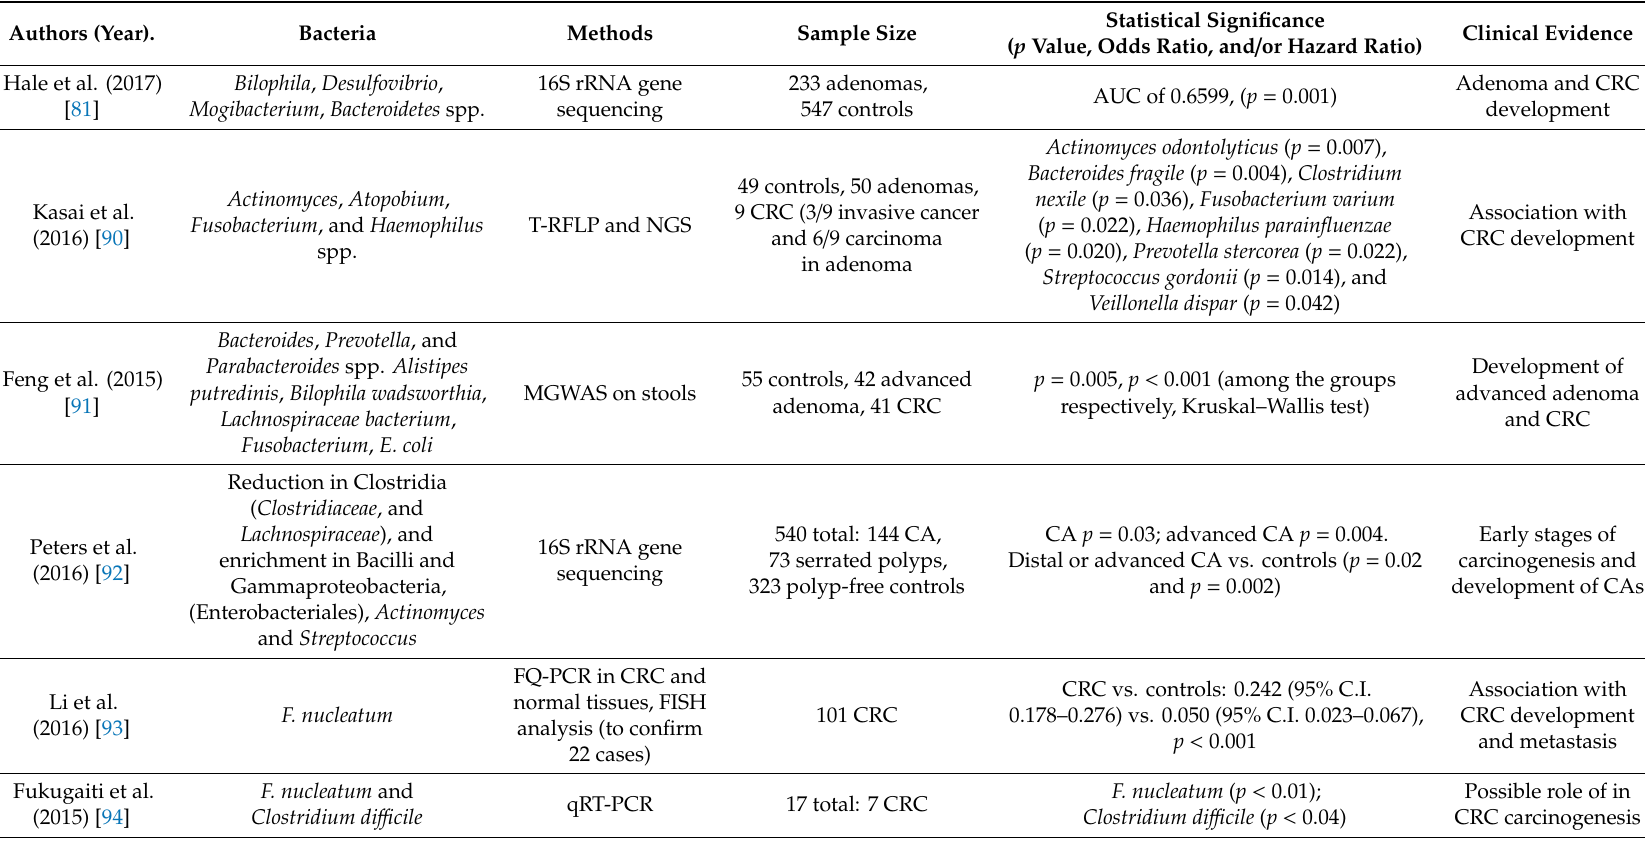
Table 1. Studies of gut bacteria associated with the development of adenoma and / or